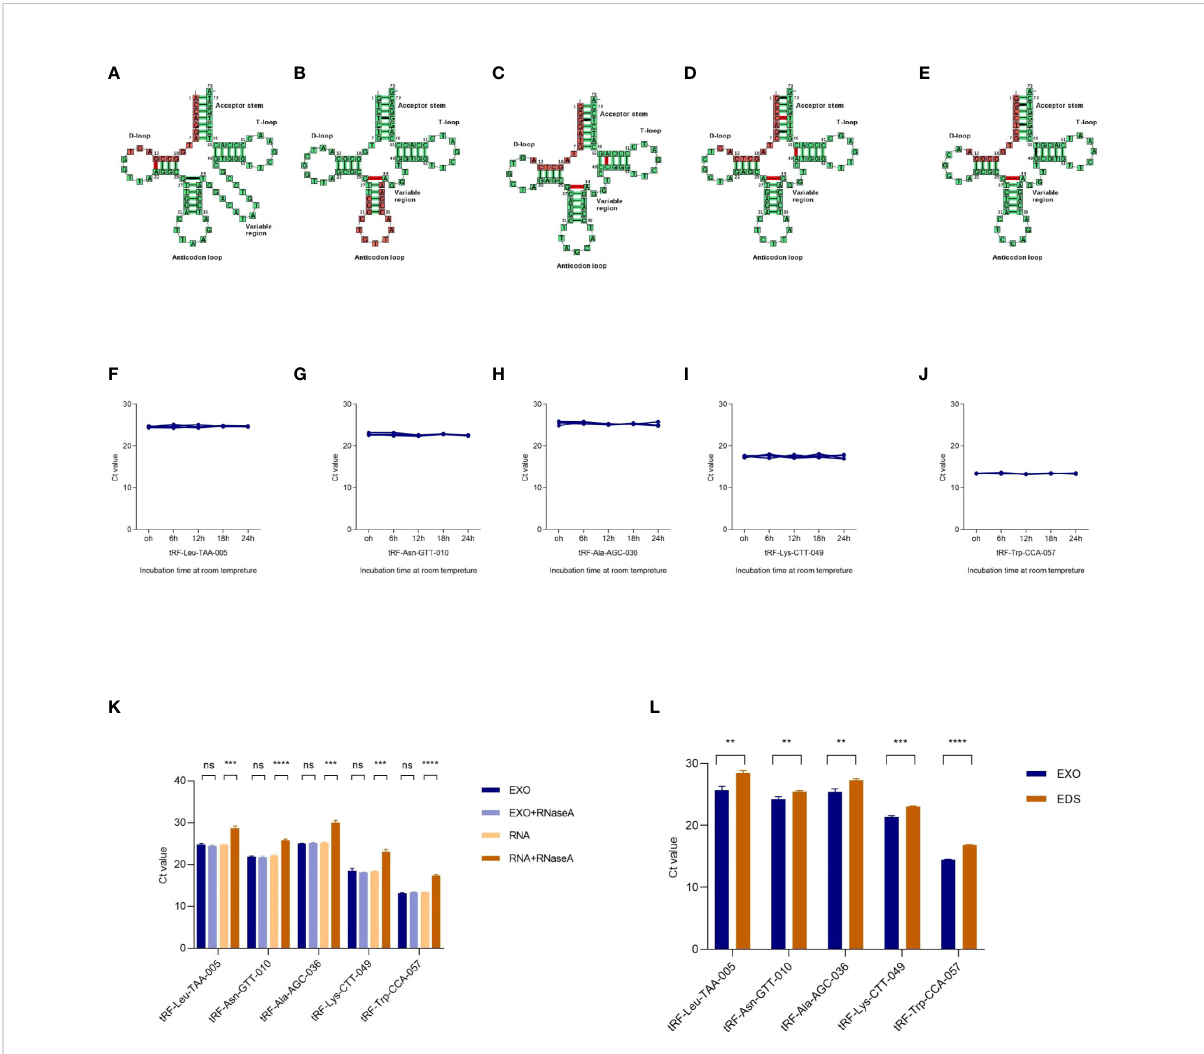
FIGURE 3 Characterization of plasma exosomal tRFs. (A – E) The cleavage site of tRF-Leu-TAA-005, tRF-Asn-GTT-010, tRF-Ala-AGC-036, tRF-Lys-CTT- 049, and tRF-Trp-CCA-057 on their own tRNA secondary structure. The levels of (F) tRF-Leu-TAA-005, (G) tRF-Asn-GTT-010, (H) tRF-Ala- AGC-036, (I) tRF-Lys-CTT-049, and (J) tRF-Trp-CCA-057 when incubated at room temperature. (K) qRT -PCR analysis of the fi ve tRFs in the exosomes or isolated nucleic acids treated with RNase A. (L) Expression levels of the fi ve tRFs from plasma exosome (EXO) and exosome- depleted supernatant (EDS) (** p < 0.01, *** p < 0.001, **** p < 0.0001, ns, not signi fi